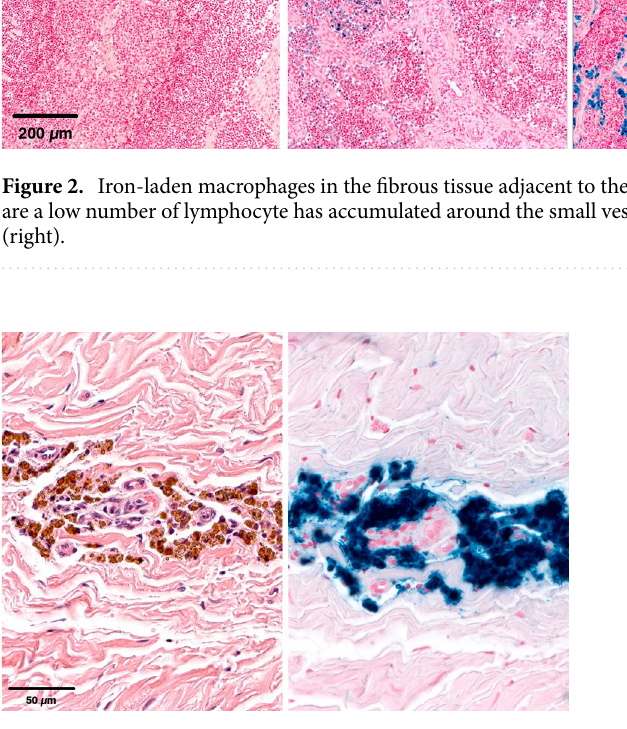
Figure 3. Demonstration of different grades of iron deposition in local lymph nodes. The iron is stored as hemosiderin within macrophages laying in the neighborhood of sinuses. Mild (left), moderate (middle) and severe (right) grade of deposition. Turnbull blue